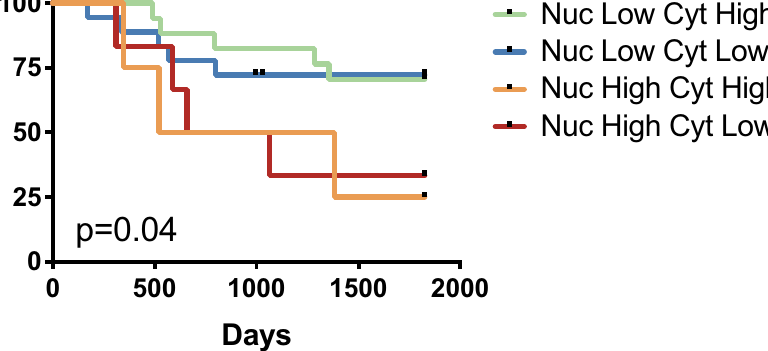
Fig. 2 TRIM24 over-expression promotes development of mammary metaplastic carcinosarcomas with similarity to tumors borne by MpBC patients with poor probability of survival. a Pie chart showing quanti fi ed classi fi cations (% of total) of Trim24 COE mammary tumors along with representative